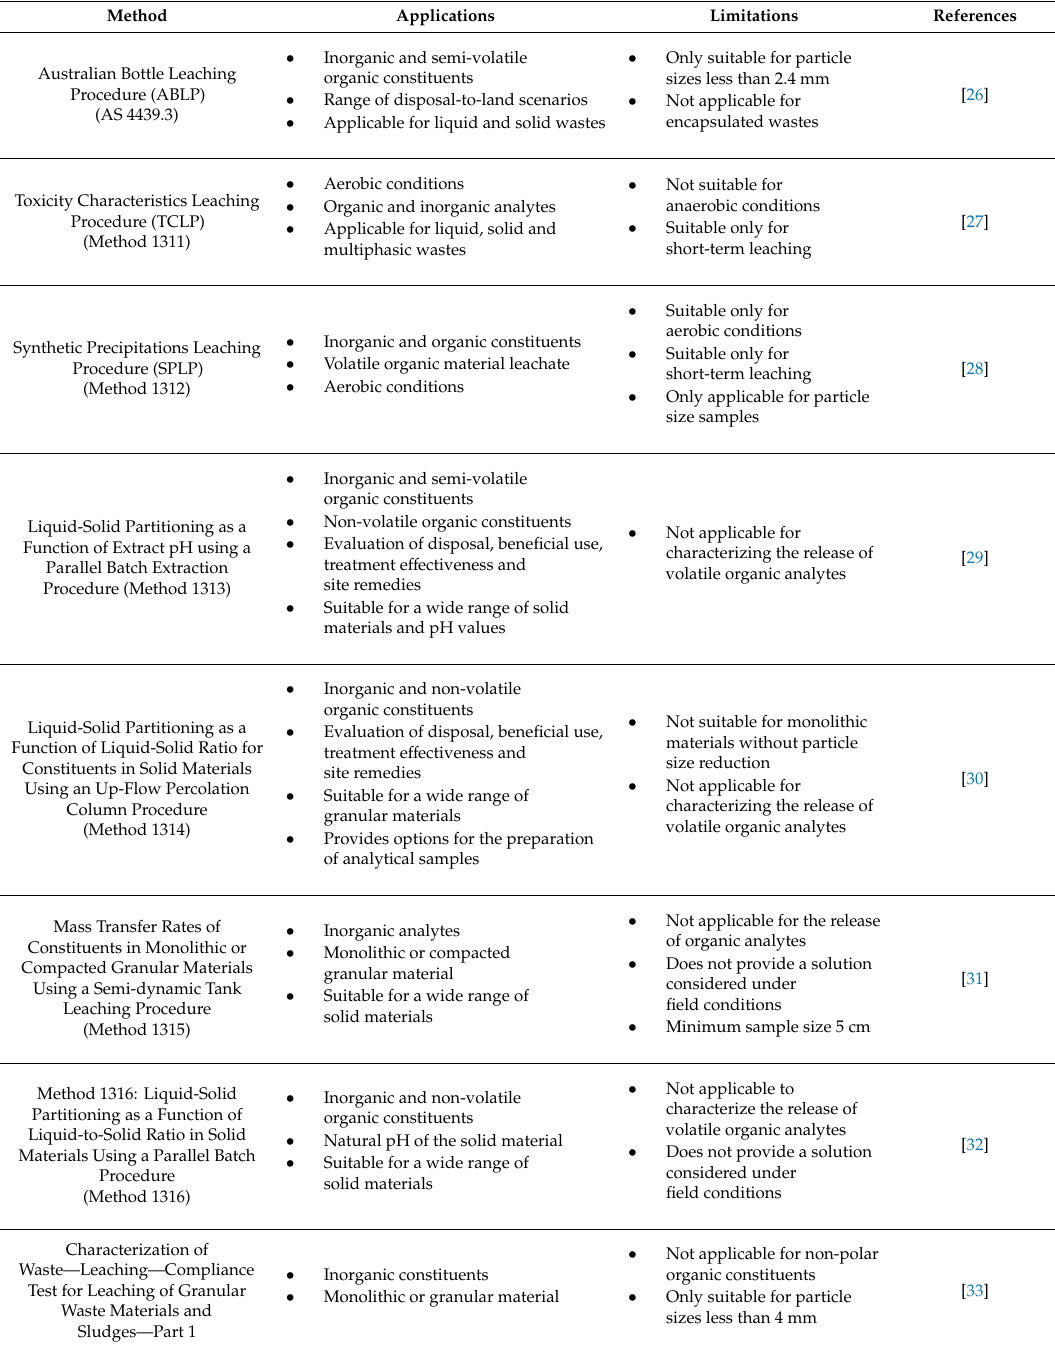
Table 1. Applications and limitations of various leachate testing